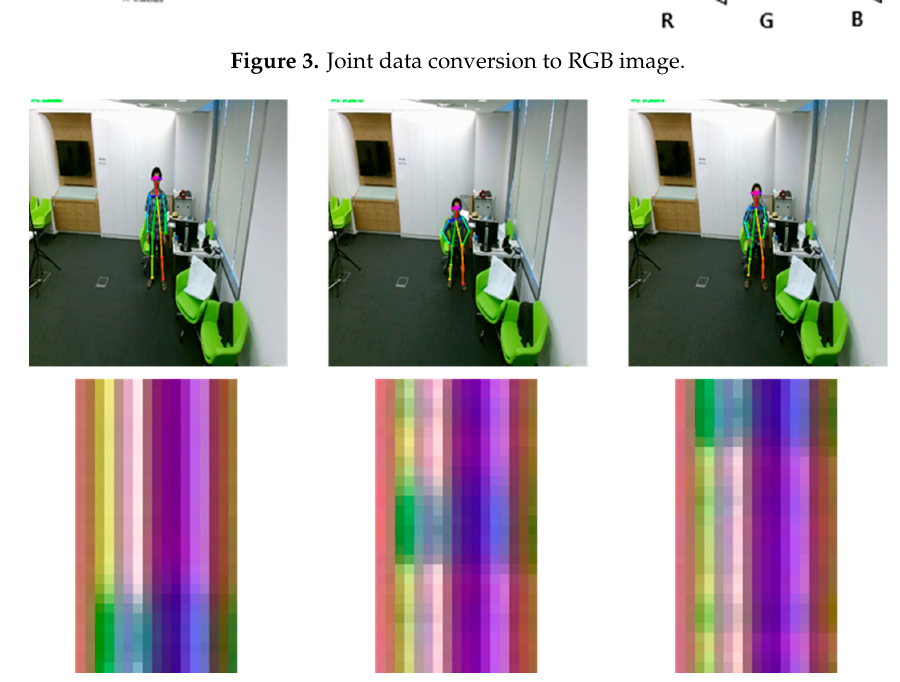
Figure 4. Converted image of the action sequence.